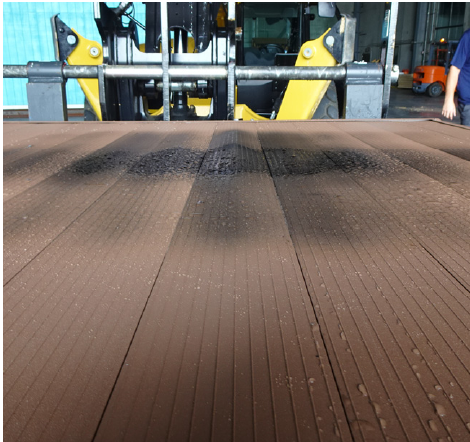
Figure 21. No-gap metal boards on SYP deck assembly after the test.